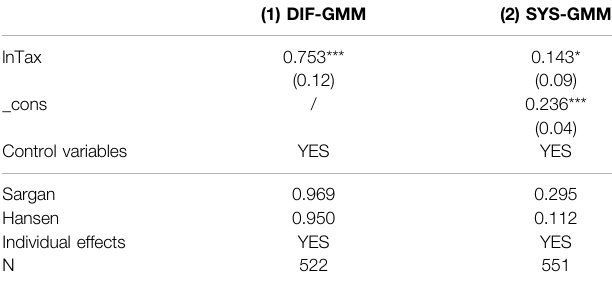
TABLE 7 | The results of the Endogenetic test.